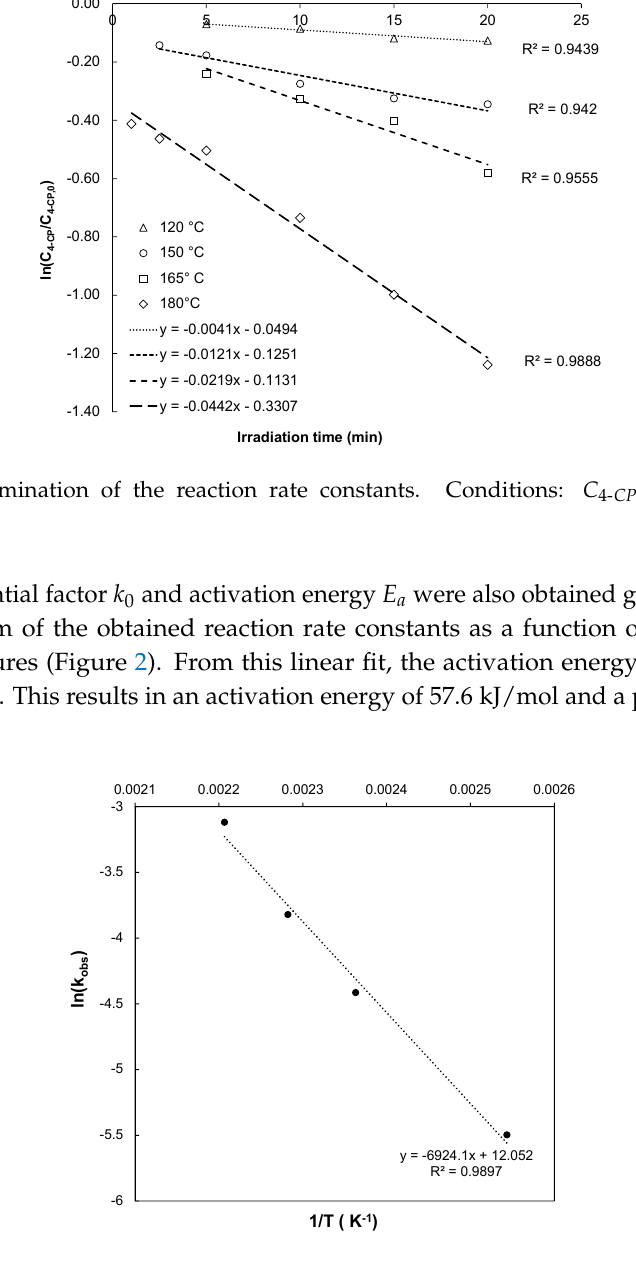
Figure 2. Determination of the activation energy and pre-exponential factor of the MW–H 2 O 2 -process.